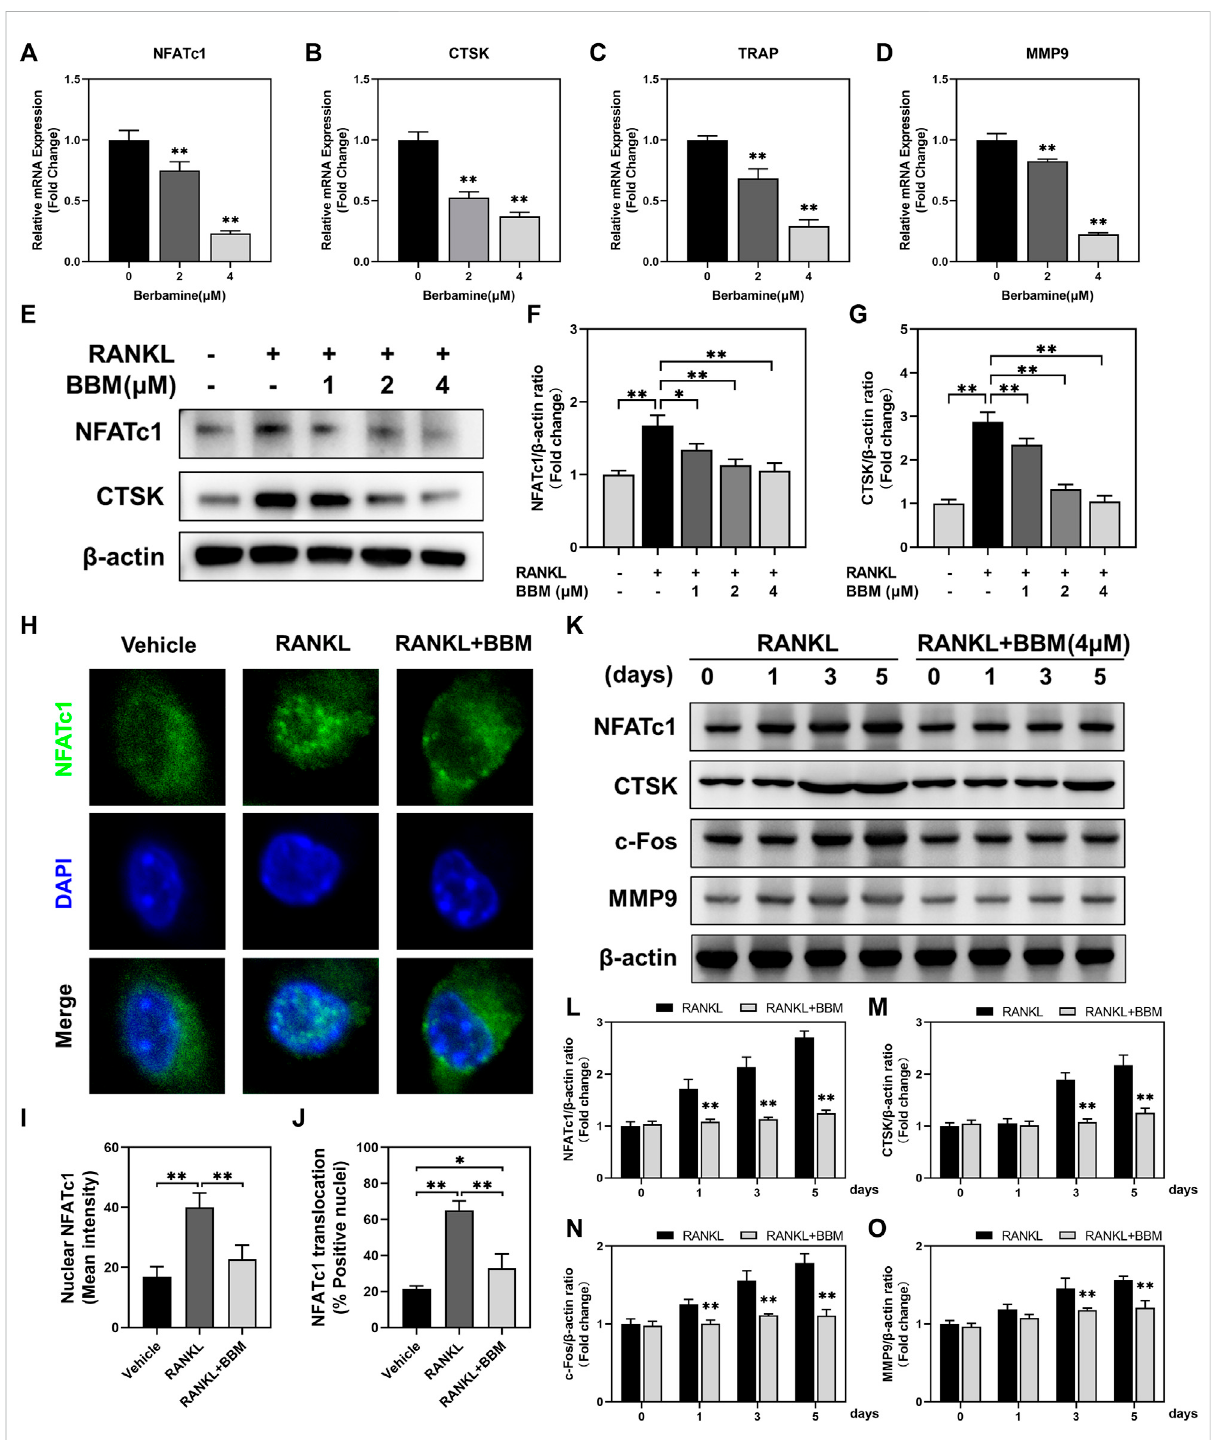
FIGURE 3 BBM suppresses the expression of osteoclast-speci fi c genes. (A – D) The mRNA expression levels of NFATc1 (A) , CTSK (B) , TRAP (C) and MMP9 (D) were determined by quantitative real-time PCR analysis and normalized to GAPDH expression. Fold change was calculated using 2 − ΔΔ CT . (E) Representative western blotting images of NFATc1 and CTSK after stimulation with or without RANKL and BBM for 5 days. (F,G) Quantitative analysis of NFATc1 (F) and CTSK (G) protein expression normalized to β -actin expression. (H) Representative confocal images of the NFATc1nucleartranslocationassayinBMMstreatedwithorwithout4 μ MBBM. (I,J) QuantitativeanalysisofthemeanNFATc1 fl uorescenceintensity in the nucleus (I) and percentage of NFATc1-positive nuclei (J) . (K) Representative western blotting images of NFATc1, CTSK, c-Fos and MMP9 after stimulation with or without 4 μ M BBM for the indicated time. (L – O) Quantitative analysis of the expression levels of NFATc1 (L) , CTSK (M) , c-Fos (N) and MMP9 (O) normalized to β -actin expression. * p < 0.05 and ** p < 0.01 compared to the control